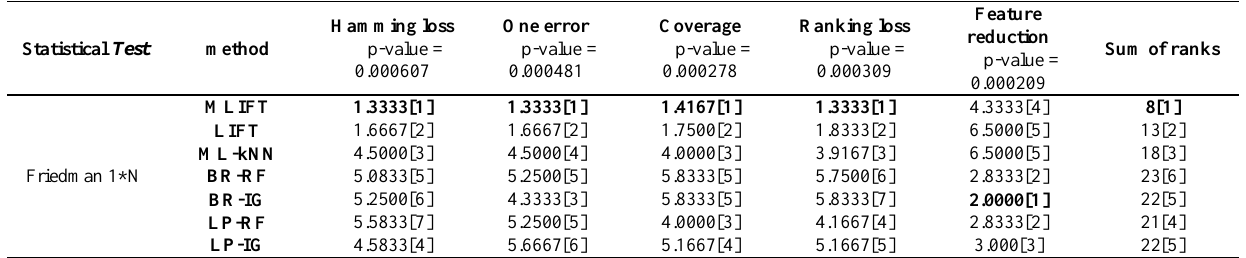
Table 1. Average rankings of the algorithms obtained by each evaluation measure by performing Friedman